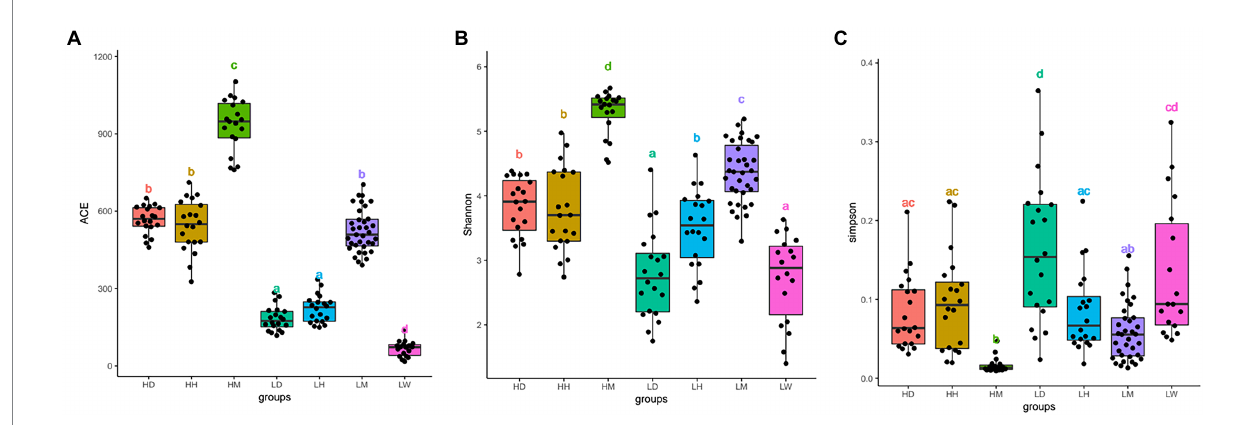
FIGURE 2 Microbiota alpha diversity analysis of fecal samples among wild macaques, humans and dogs in high altitude and low altitude environments. The alpha diversity among different groups (A) ACE index; (B) Shannon diversity; (C) Simpson diversity. The same letter indicates the difference is not significant (T-test, p > 0.05). HH stands for high altitude humans, HD stands for high altitude dogs, HM stands for high altitude wild macaques, LH stands for low altitude humans, LD stands for low altitude dogs, LM stands for low altitude wild macaques, LW stands for low